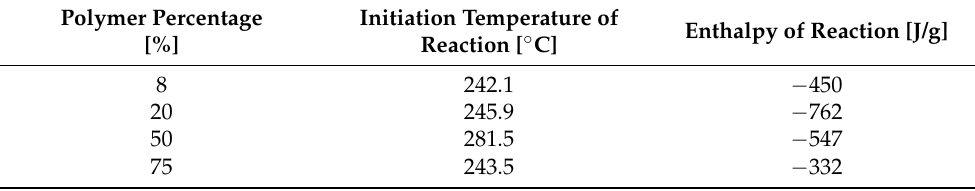
Table 3. Results of DSC analysis of AN and soft PS mixture with different proportions.